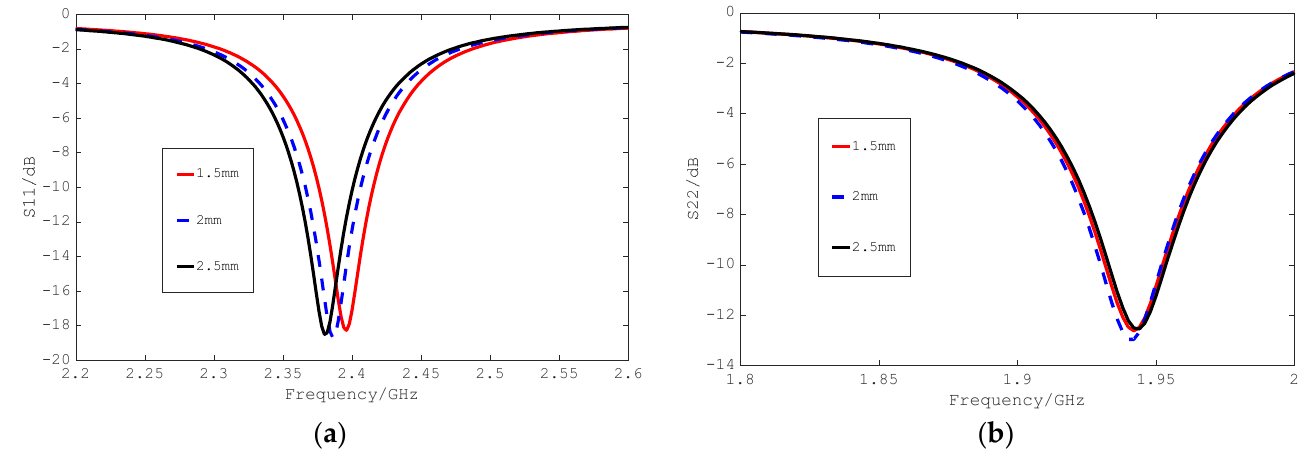
depths. ( a ) Port 1. ( b ) Port 2.